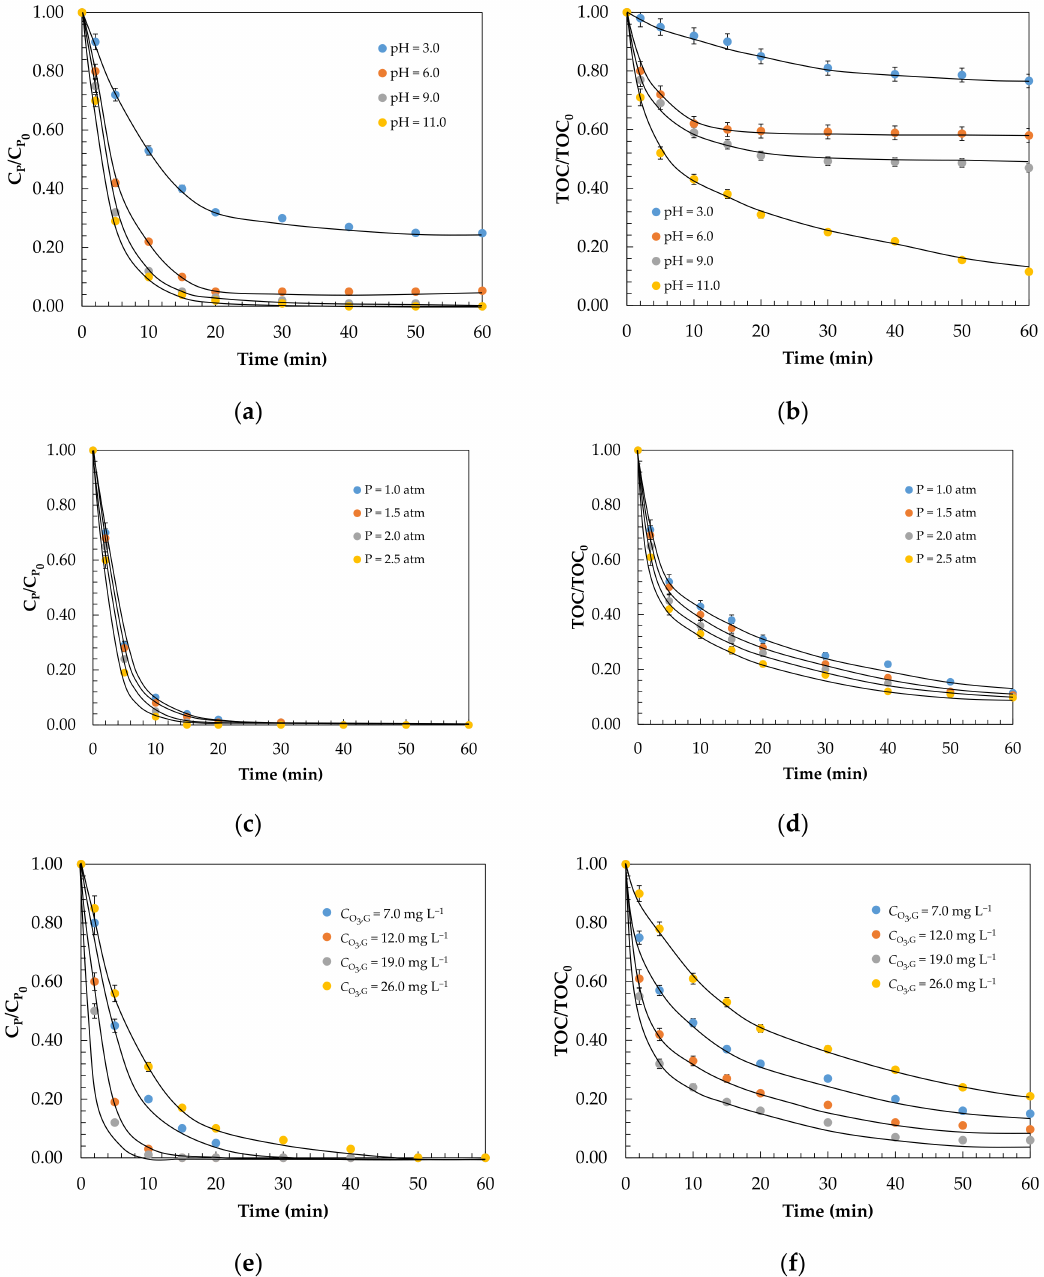
Figure 4. Effect of operational conditions on the primary degradation and mineralisation of phenol-containing waters during a catalytic ozonation process with GAC: ( a , b ) pH 1 , ( c , d ) pressure 2 , and ( e , f ) ozone concentration at inlet 3 , showing the experimental profiles and fitted to the Ad/Ox kinetic model. Experimental conditions: 1 C P